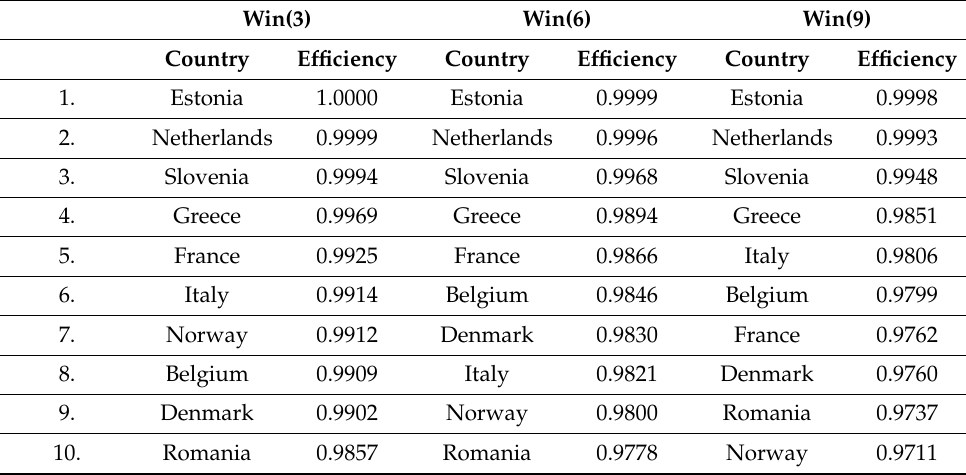
Table A3. Window analysis results with different window width for the reference period